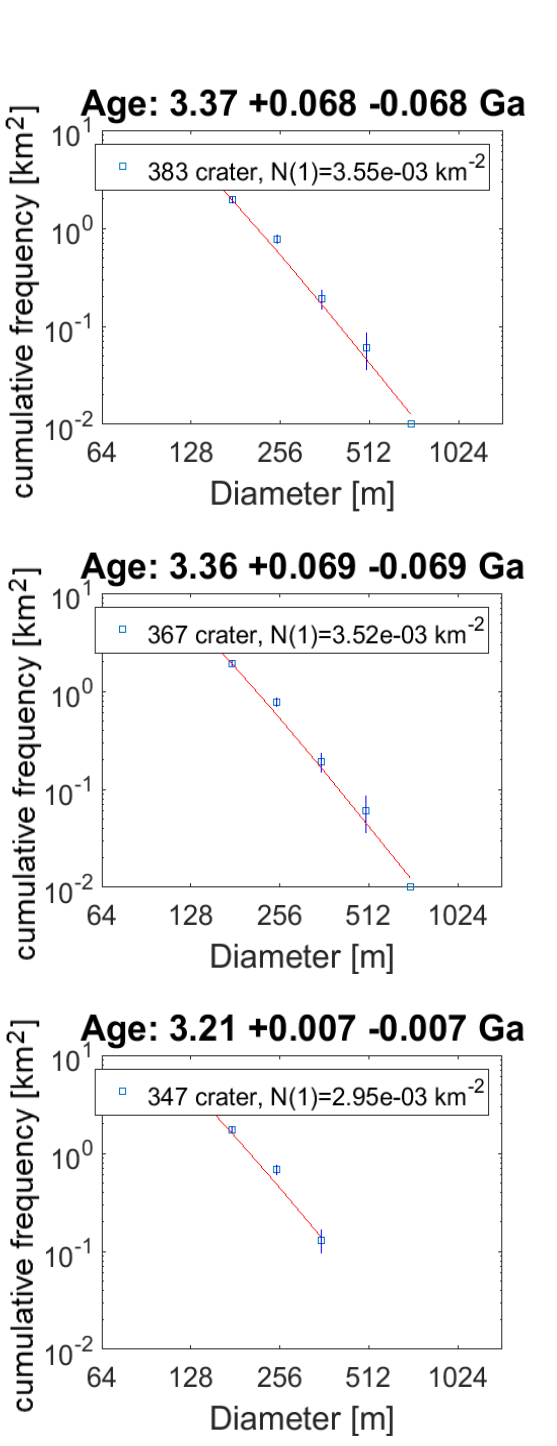
Figure 5. AMA estimation for the reference area, obtained using the template matching algorithm without SCD (top), with SCD algorithm without bins (middle) and with binned SCD algorithm